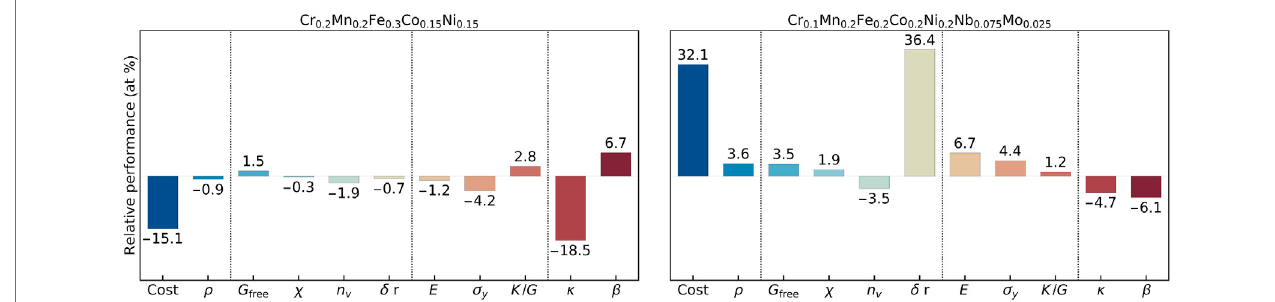
FIGURE 7 | Optimized candidate compositions for fi ve- and seven-principal-elements high-entropy alloys for thermally well-insulated components, operating at high temperatures. The Wendland radial basis functions are used for interpolating the compositional spaces.